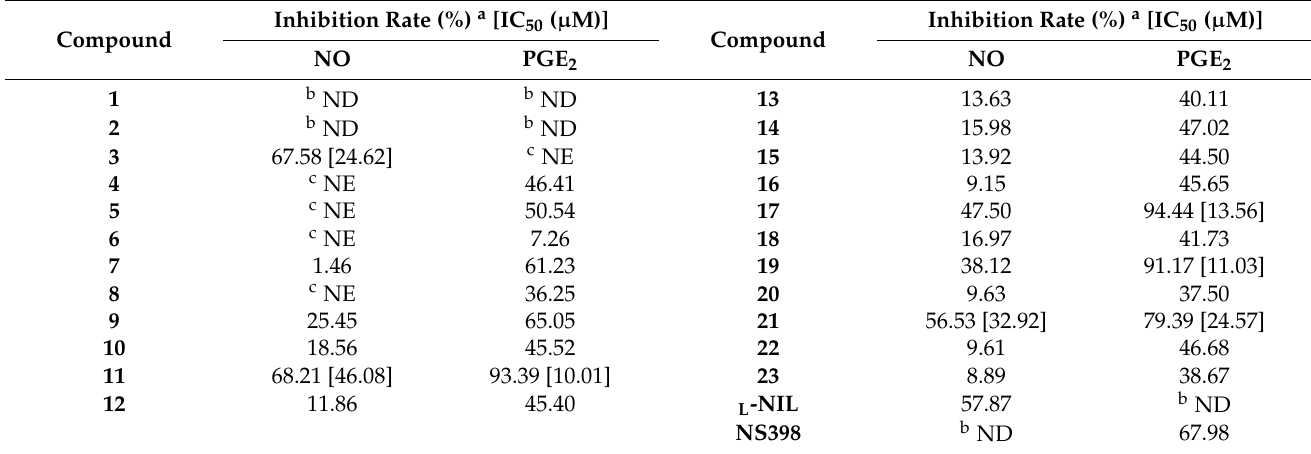
Table 1. The inhibitory activities of compounds 1 – 23 obtained from the roots of P. tenuifolia on LPS-induced NO and PGE 2 production in RAW 264.7 macrophages. L -NIL and NS398 are positive control for NO production and PGE 2 production, respectively.